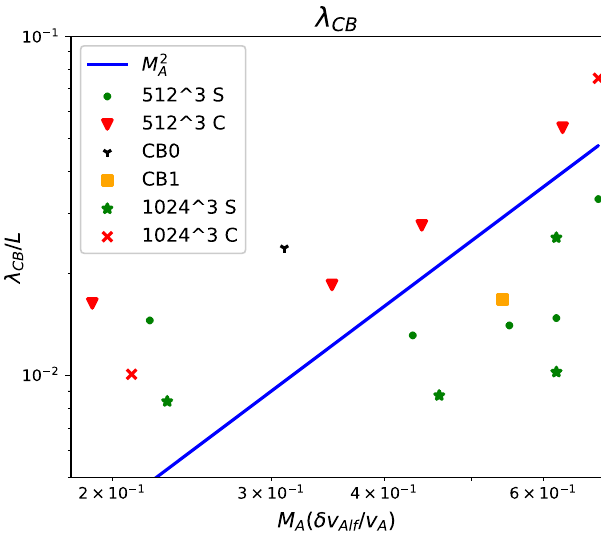
FIG. 10. The variation of the estimated transition scale of weak to strong turbulence λ with the Alfv´enic Mach number M A . The CB different markers are the results from the different simulations, where S stands for solenoidal and C for compressive runs. The Alfv´enic Mach number is calculated from the decomposed Alfv´en data. The blue line shows the M 2 A reference